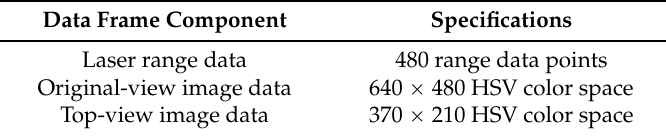
Table 5. Data frame specification.